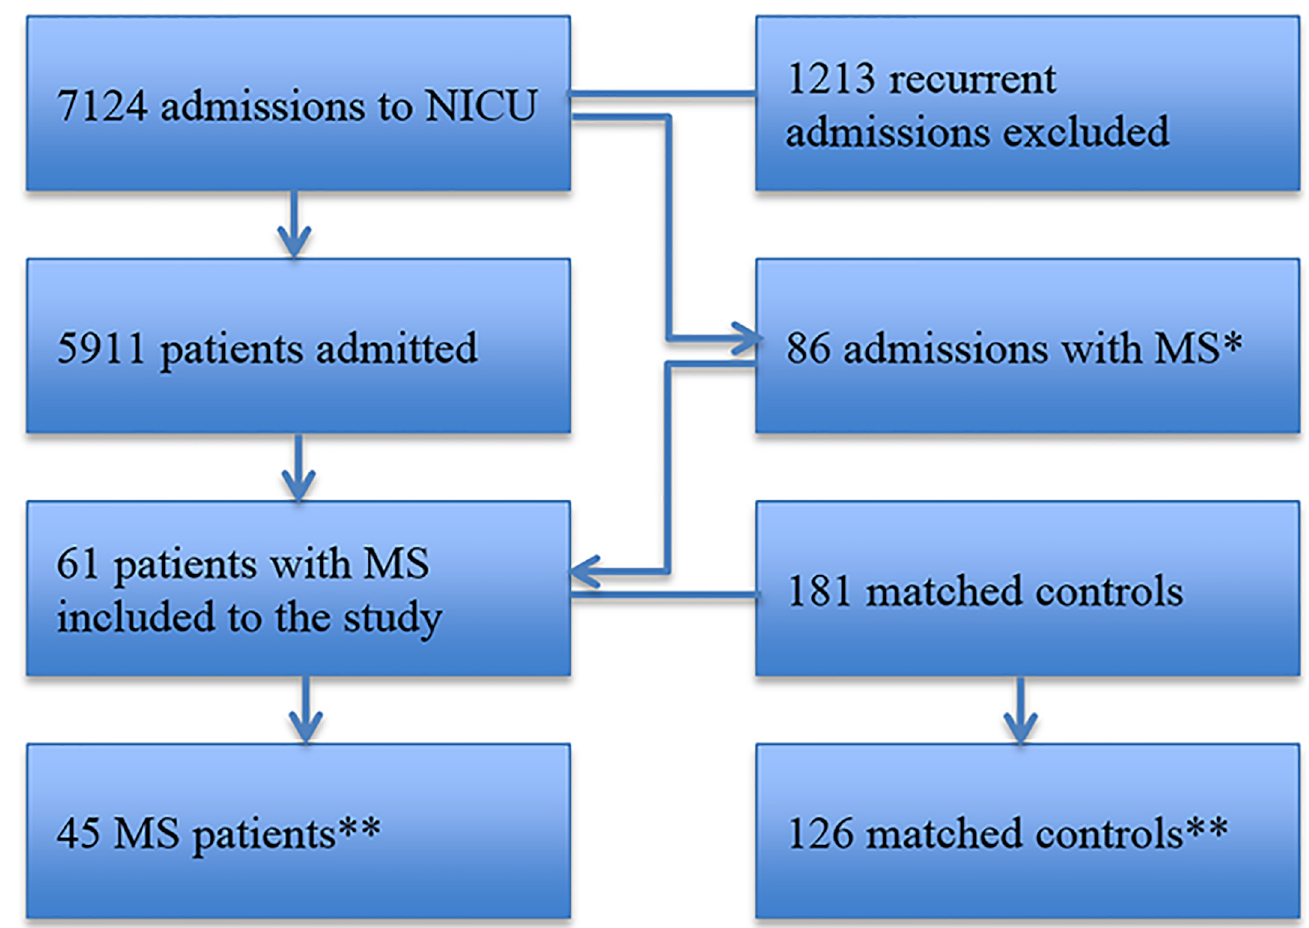
Fig 1. Patient population flowchart. * Admissions for plasmapheresis series (usually a total of 5 exchanges administered every other day) were considered as a single admission. ** After excluding admissions for a planned intervention and adjusting the matching for mortality analysis.